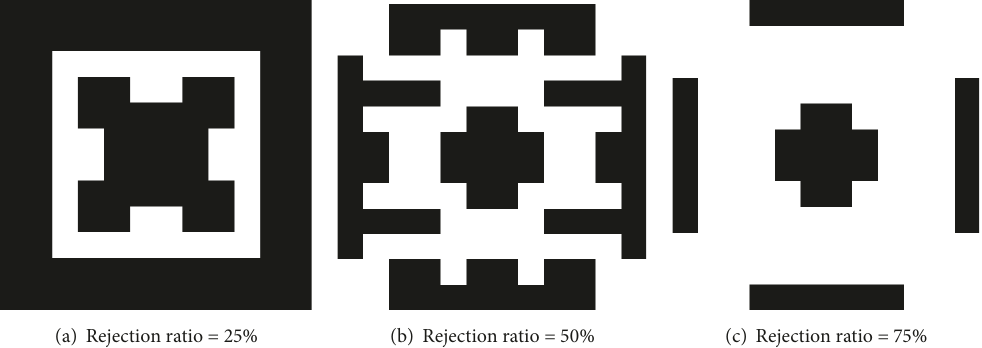
Figure 12: Optimal CLD layouts obtained using GA under various rejection ratios for first BC.